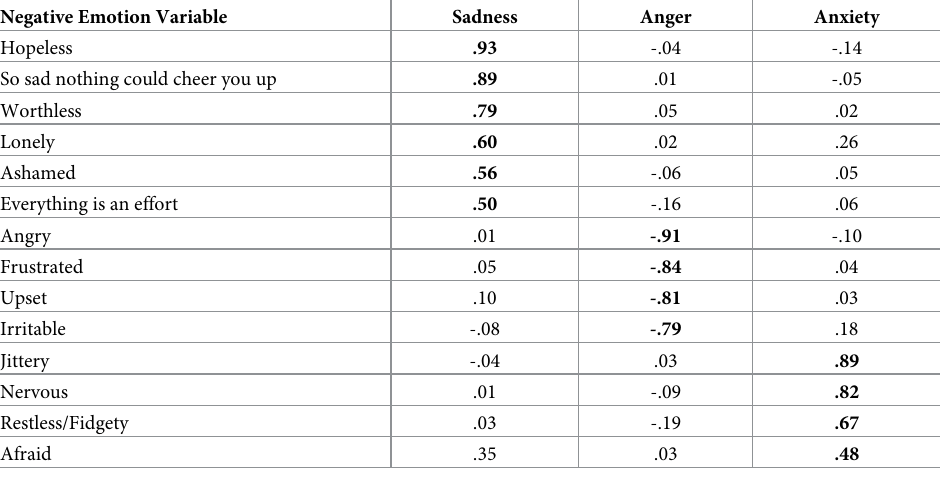
Table 1. Pattern matrix of negative affect items. Negative Emotion Variable Sadness Anger Anxiety .93 -.04 -.14 .89 .01 -.05 Worthless .79 .05 .02 Lonely .60 .02 .26 Ashamed .56 -.06 .05 Everything is an effort .50 -.16 .06 Angry .01 -.91 -.10 .05 -.84 .04 .10 -.81 .03 Irritable -.08 -.79 .18 -.04 .03 .89 Nervous .01 -.09 .82 Restless/Fidgety .03 -.19 .67 Afraid .35 .03